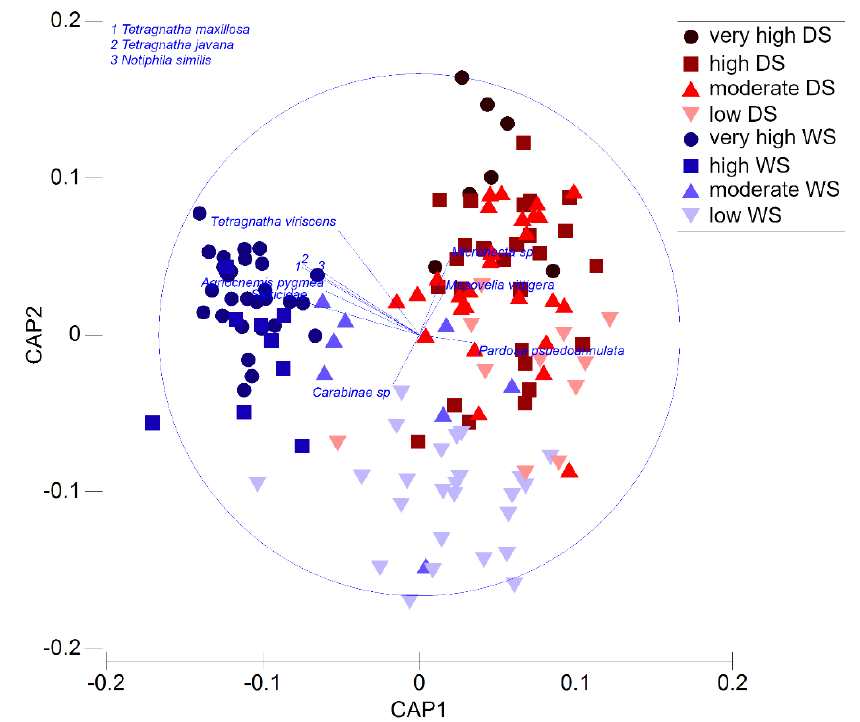
Figure 5. Canonical Analysis of Principal Coordinates (CAP) showing differences in predator species composition between blow-vac samples. Red colors indicate samples collected during the dry season (DS), whereas blue colors indicate samples collected during the wet season (WS). Prey abundance levels are represented by increasing color darkness. Prey (including all herbivores and decomposers) abundance is based on the quartiles of the total invertebrate abundance of all samples (low = <51, moderate = 51–95, high = 96–169, very high = 170–456). Overlayed vectors (in blue) represent the correlations (Pearson’s correlation coefficient > 0.3) between predator species and the CAP axes, where vector length and direction reflect the increasing values of correlation and parameter values, respectively.